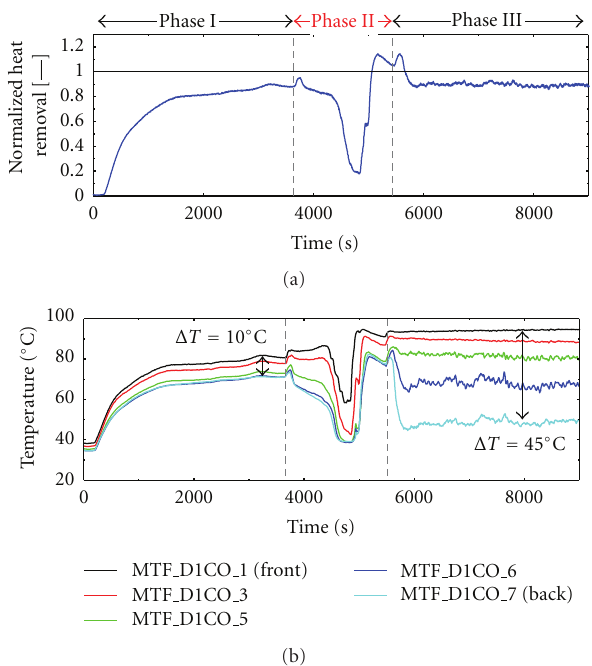
Figure 7: Normalized heat removal and water outlet temperature of the subchannels for test ST4 2(